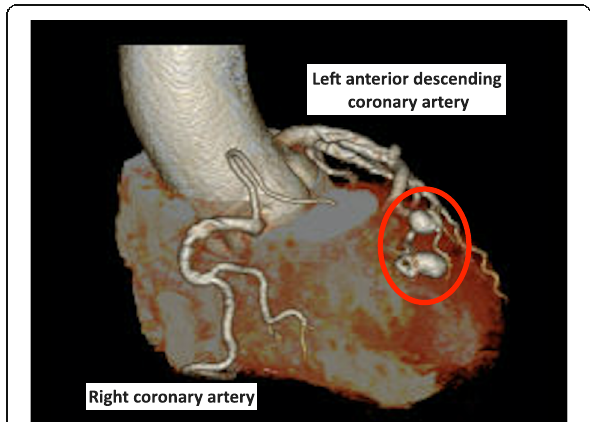
Fig. 1 Preoperative coronary 3D-CT: Two coronary artery aneurysms are recognized in the periphery of the left anterior descending branch (red